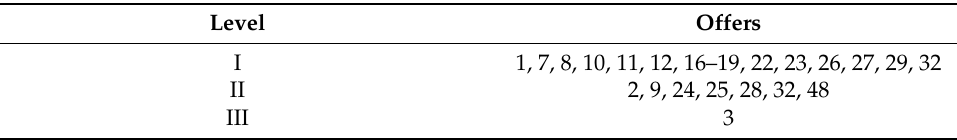
Figure 2. Structure of dominance for offers. Table 2. Complete dominance hierarchy